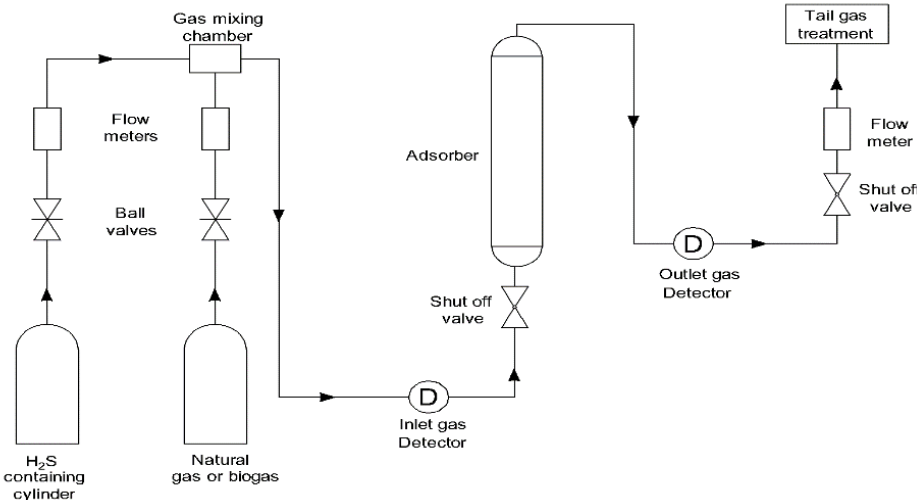
Figure 1. Typical experimental laboratory setup for the removal of H 2